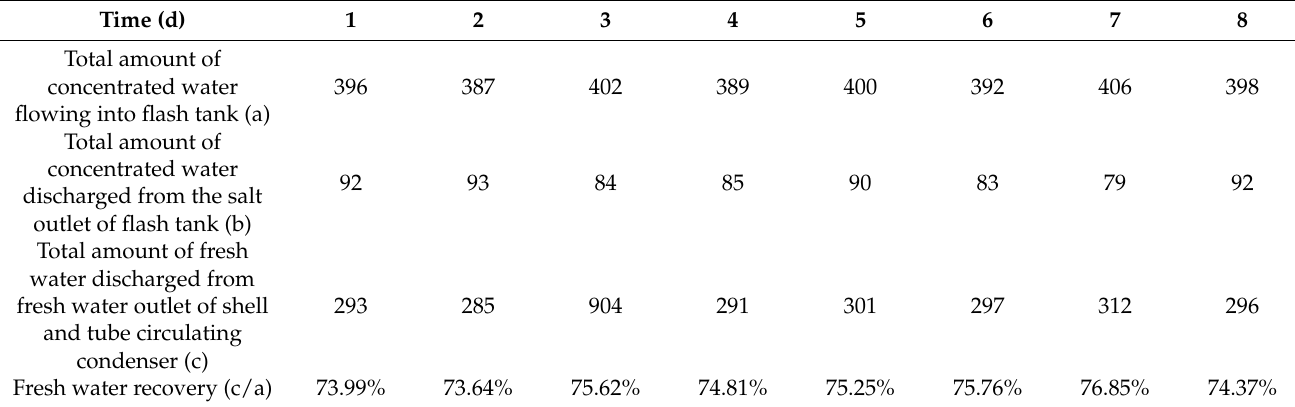
Table 3. Recovery rate of fresh water.